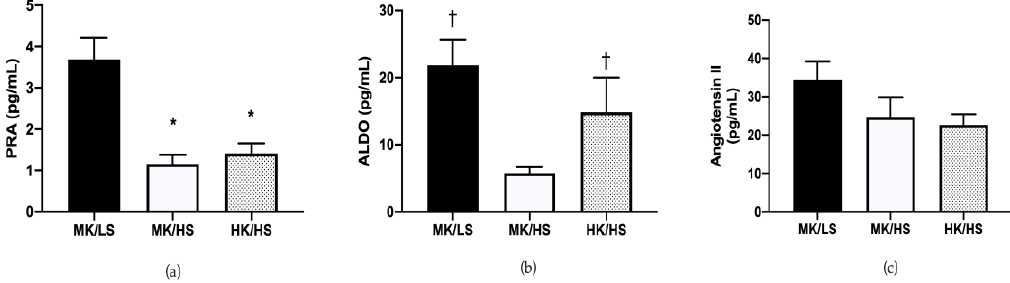
Figure 2. ( a ) Plasma renin activity (PRA) was suppressed on the high sodium diets. ( b ) Aldosterone (ALDO) levels were elevated on the MK/LS and HK/HS diets relative to MK/HS. ( c ) Angiotensin II levels were not significantly different between the three diets. HK/HS, high potassium/high sodium; MK/HS, moderate potassium/high sodium; MK/LS, moderate potassium/low sodium. Values are mean ± SE. * p < 0.05 vs. MK/LS; † p < 0.05 vs. MK/HS.